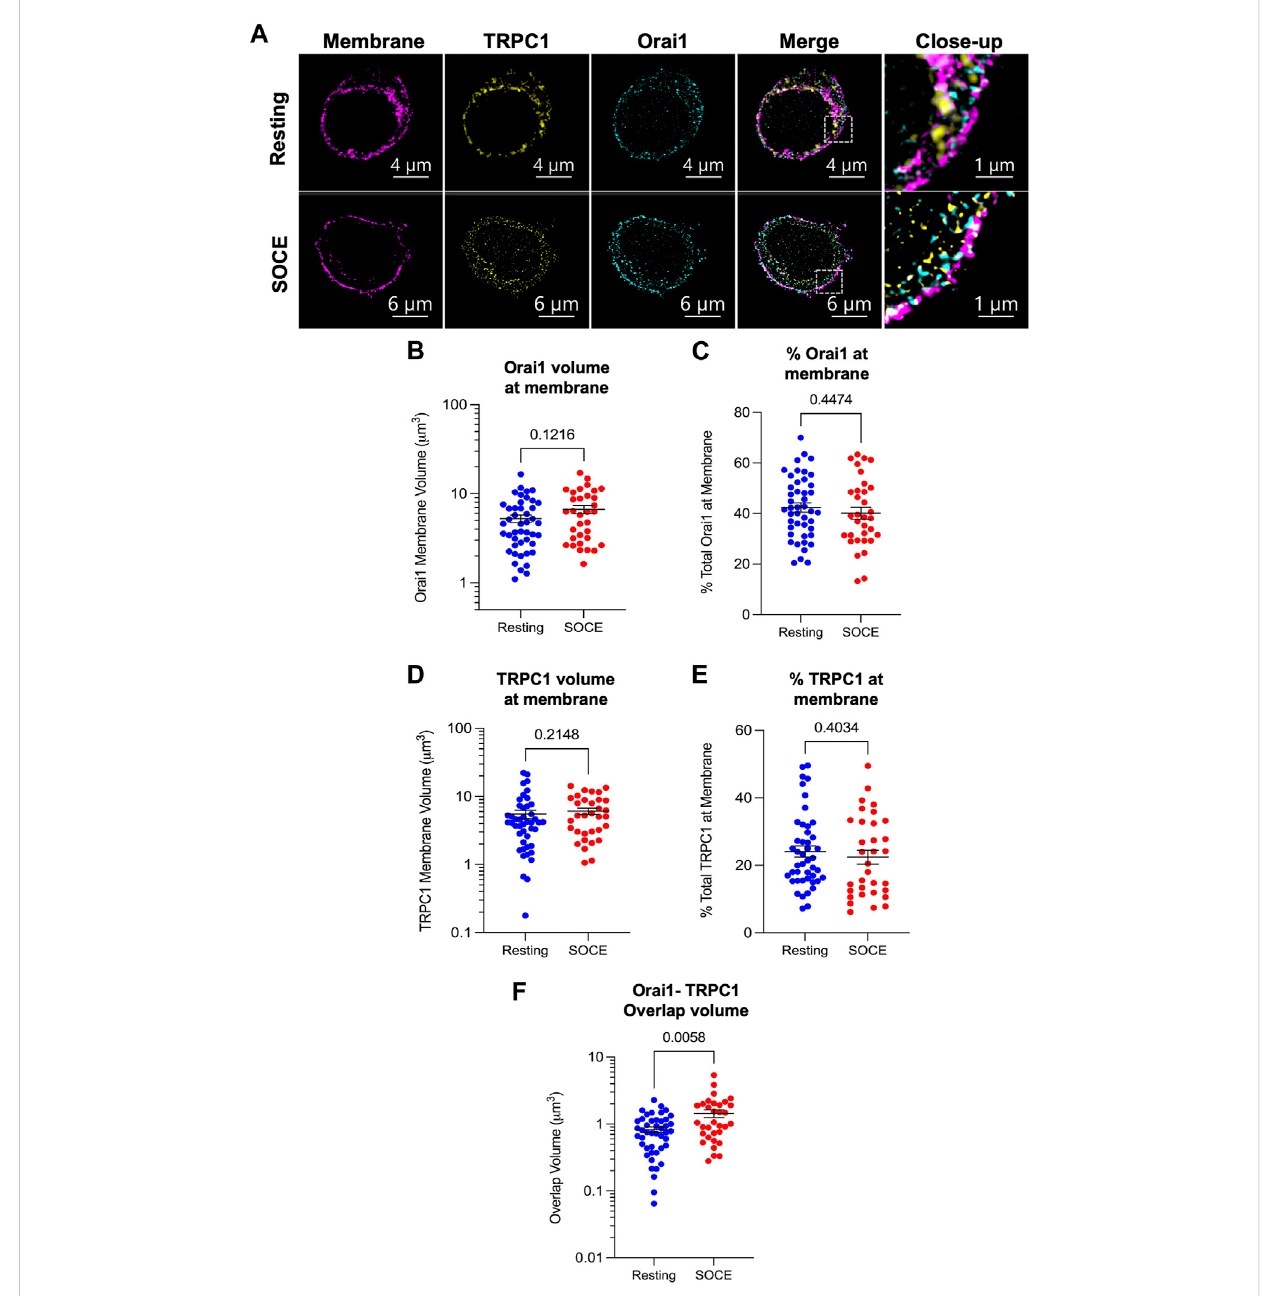
FIGURE 2 Orai1 and TRPC1 co-localize during SOCE but membrane levels of both proteins remain constant. (A) Representative lattice-SIM immuno fl uorescent images of HaCaT cells fi xed in a resting state (upper panel) or following activation of store-operated Ca 2+ entry (lower panel). Cells were stained for the plasma membrane (CellBrite 555 Fix), and with antibodies against TRPC1 and Orai1. Images show a transverse slice from a z-stack which was used to construct 3D models for co-localization analysis. Staining for TRPC1 and Orai1 was identi fi ed using the surfaces methodology in Imaris v9.8 (see Section 2). Surfaces of TRPC1/Orai1 signal were fi ltered to staining coincident with the plasma membrane stain and watershed to represent individual clusters of fl uorescence signal. Resultant surfaces were analysed for overlap of Orai1 (B,C) , TRPC1 (D,E) and with the plasma membrane stain and for total overlapping volume of Orai1-TRPC1 (F) under both resting (blue) and SOCE (red)